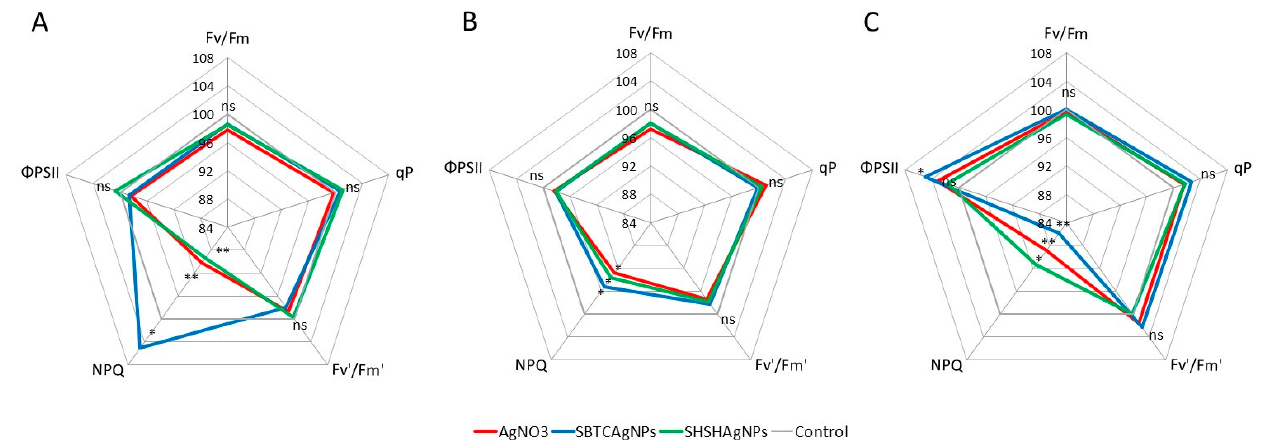
Figure 3. Parameters of slow kinetic fluorescence of chlorophyll a in leaves of the control and the AgNO 3 -, SBTCAgNPs- and SHSHAgNPs-treated wheat plants after the 3rd ( A ), 4th ( B ) and 5th ( C ) week of growth. The following parameters were measured: maximum quantum yield in dark-adapted (Fv/Fm) and light-adapted (Fv ′ /Fm ′ ) leaves, current quantum yield ( φ PSII), photochemical quenching (qp) and non-photochemical quenching (NPQ). The presented data (arbitrary units) are mean values for the silver-treated plants, expressed as a percentage of the control values based on 10 replicates. Significant differences to the control are given by asterisks: ** p < 0.01; * p <